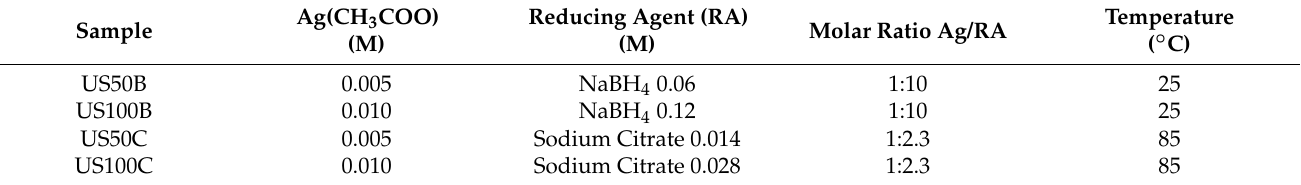
Table 1. Reaction